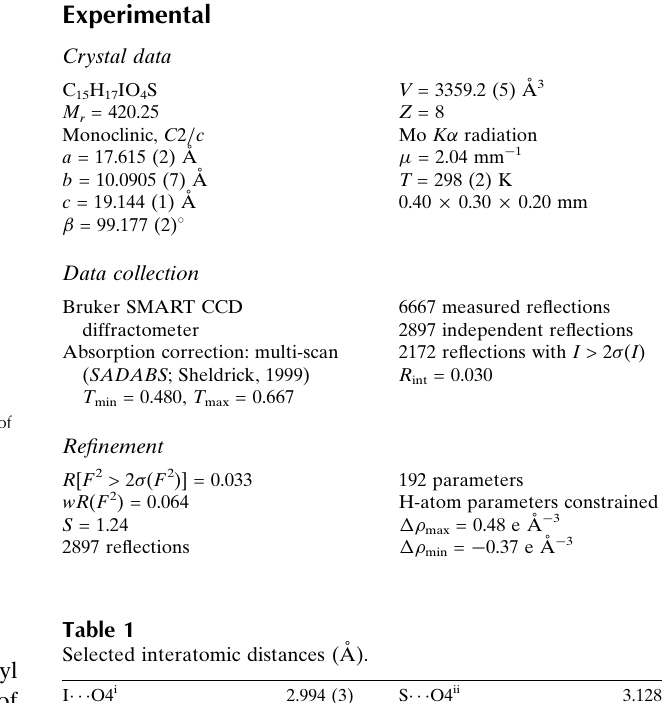
Selected interatomic distances (A˚